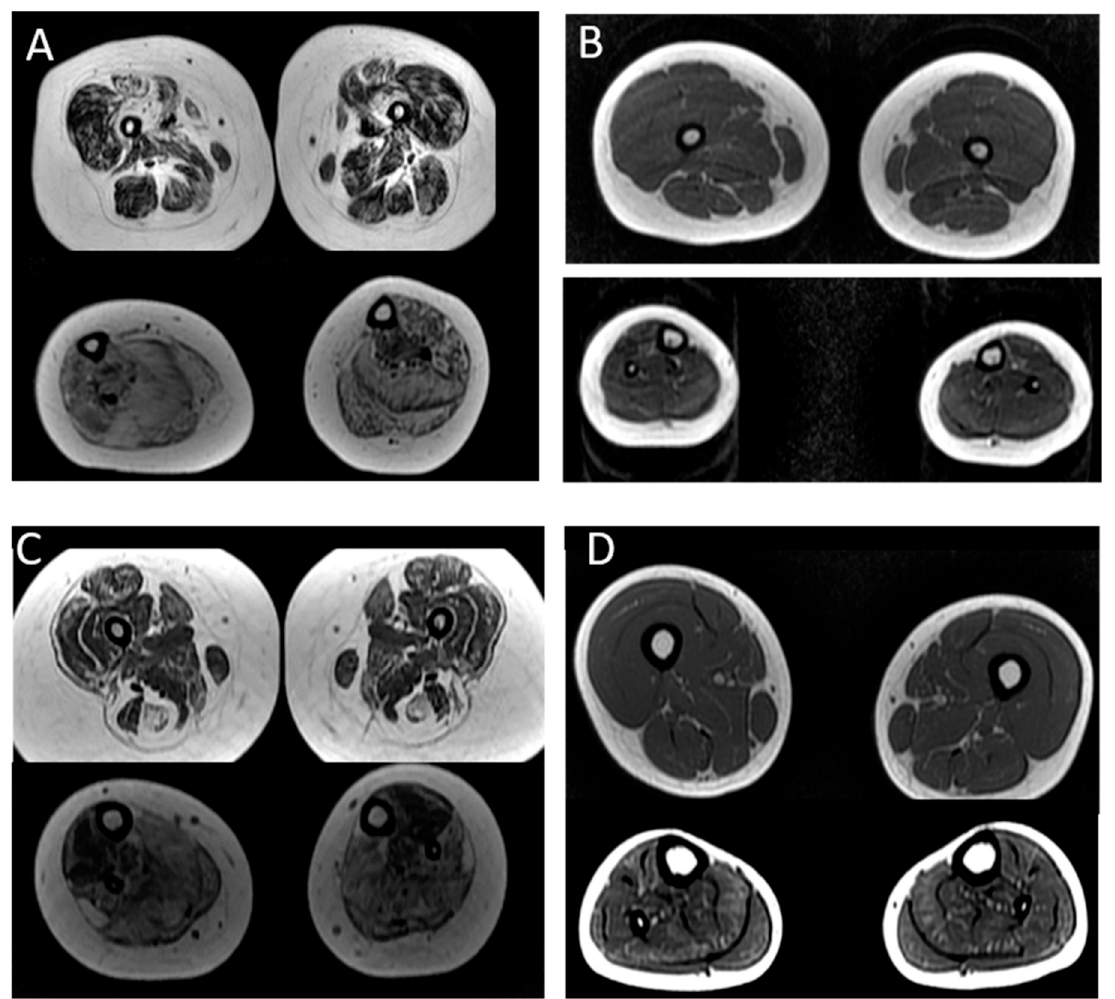
Figure 2. MRI pattern in patients with mutations in the ACTA1 and NEB genes: ( A , B ) patients with mutations in the ACTA1 gene. In ( A ), there is a diffuse infiltration in the thigh and legs in P3 (severe form); in ( B ), there is isolate involvement of tibial anterior in the legs in P2 (typical form). ( C , D ) patients with nebulin mutations; in ( C ), we observe a diffuse infiltration in the thigh and legs in a patient with severe weakness who never walked (P21); In ( D ), we observe that the predominant involvement was in the anterior tibial and soleus muscles, while the thigh muscles were spared (P15).